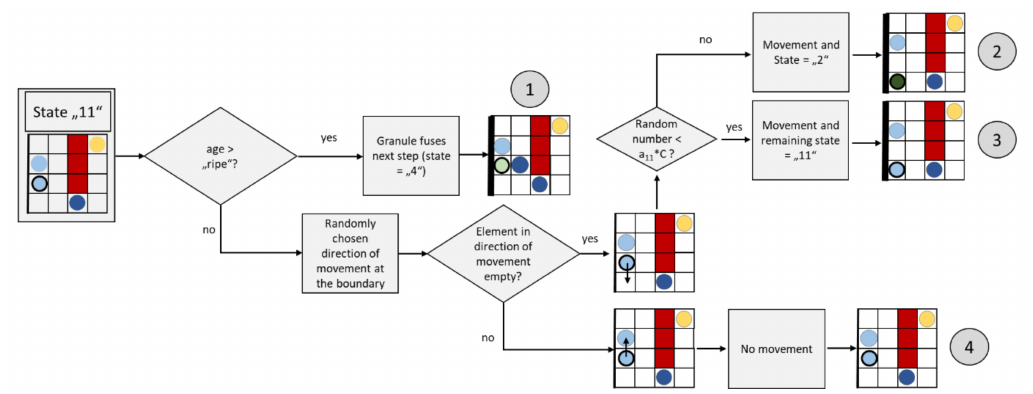
Figure 14. Flowchart for the update rule of a granule at the membrane (state